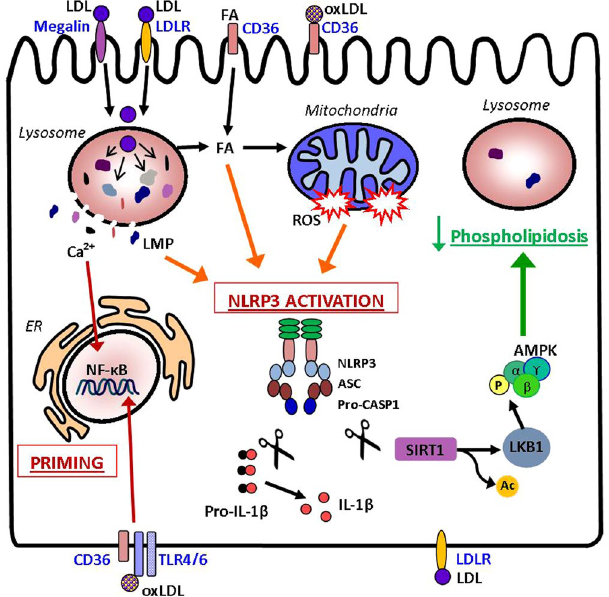
Figure 6. Lipotoxicity-induced NLRP3 inflammasome activation in TEC. After uptake by TEC via LDLR and megalin 36 , LDL particles are deliver to lysosomes for degradation releasing free-cholesterol and fatty acids (FA). FA can be directly uptaken by CD36 and boost mitochondria oxidation. oxLDL is recognized by CD36 and TLR4-TLR6 heterodimers. Excessive phagocytosis and impaired lysosomal hydrolysis of LDL particles cause phospholipidosis and lysosomal membrane permeabilization (LMP) allowing the release of lipase, cathepsins and Ca 2 + into the cytoplasm. Lipoproteins and FA palmitate loading and calcium efflux can drive mitochondrial damage and ROS accumulation dropping ATP production and ATP-dependent functions. These effects occur in consequence to native and oxidized LDL uptake. NLRP3 inflammasome activation requires 2 signals: the 1 st for priming and the 2 nd for assembly. Priming is accomplished by NF- κ B nuclear translocation induced by TLR4/6 and Ca 2 + signaling. Lysosomal destabilization, mitochondrial damage, ROS, and saturated FA account for NLRP3 complex oligomerization and caspase-1 activation that in turn cleaves pro-IL-1 β (maturation) and SIRT1 (inactivation). When activated, SIRT1 can deacetylate LKB1 allowing LKB1-mediated phosphorylation/ activation of AMPK, an essential fuel gauge and promoter of mitochondrial β -oxidation and lipid catabolism. Thus, the metabolic stress-NLRP3/CASP1-SIRT1 cleavage pathway suppresses catabolic processes worsening the intralysosomal lipid deposition in TEC. Red arrows: priming; orange: NLRP3 activation; green: process counteracting